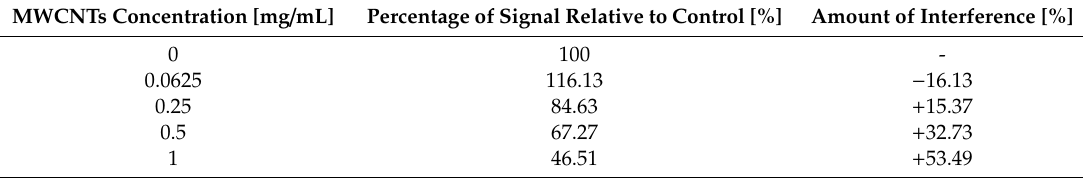
Table 1. Table showing the amount of MWCNTs interference with the luminescent signal generated by the viability assay, with a fixed amount of ATP.